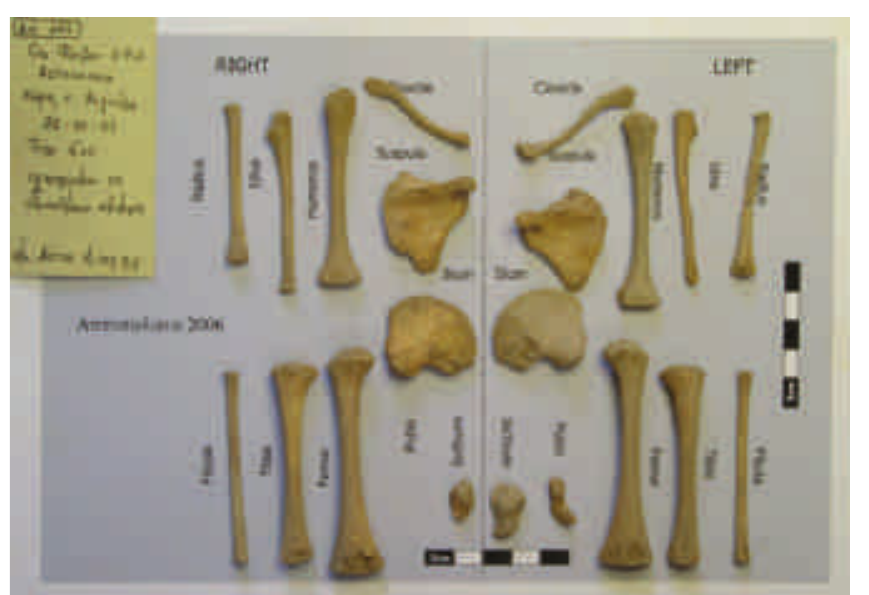
Figure 9 The post-cranial remains of a